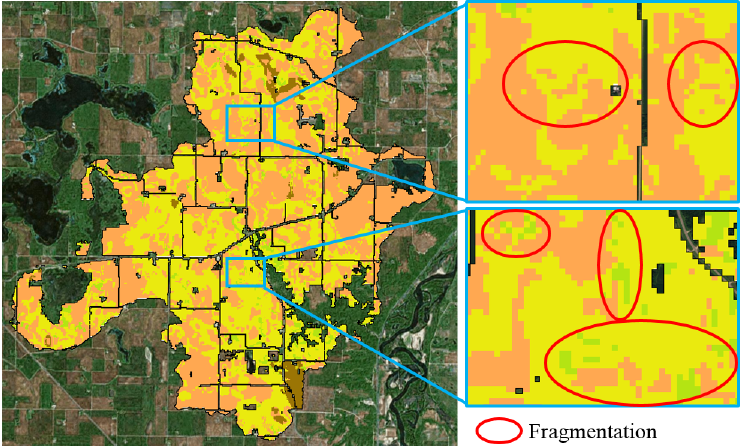
Figure 9. Example of land fragmentation in integer programming solution without spatial